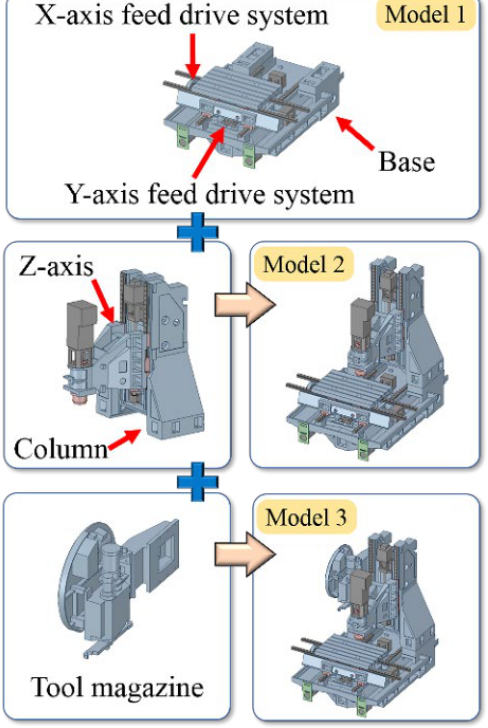
Figure 5. Structural grouping and series relationship.